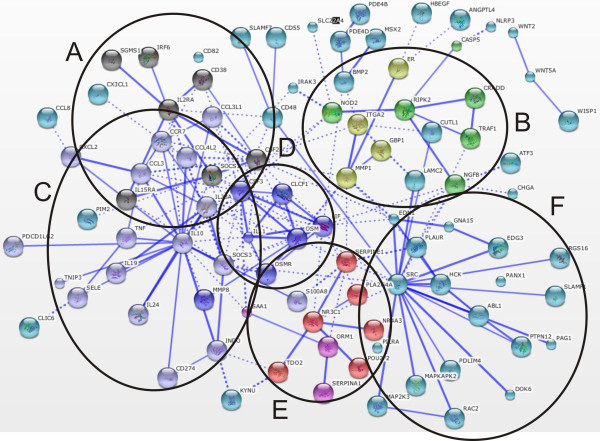
The gene functional clusters identified for the significant, upregulated adipose tissue transcriptome. The upregulated adipose tissue network (n = 7) contained 6 functional clusters:: (A) regulation of cytokine signaling; (B) cell adhesion & apoptosis; (C) IL-10 signaling; (D) growth and differentiation of hematopoietic cells; (E) glucocorticoid receptor signaling & acute phase response; (F) plasminogen activation system.